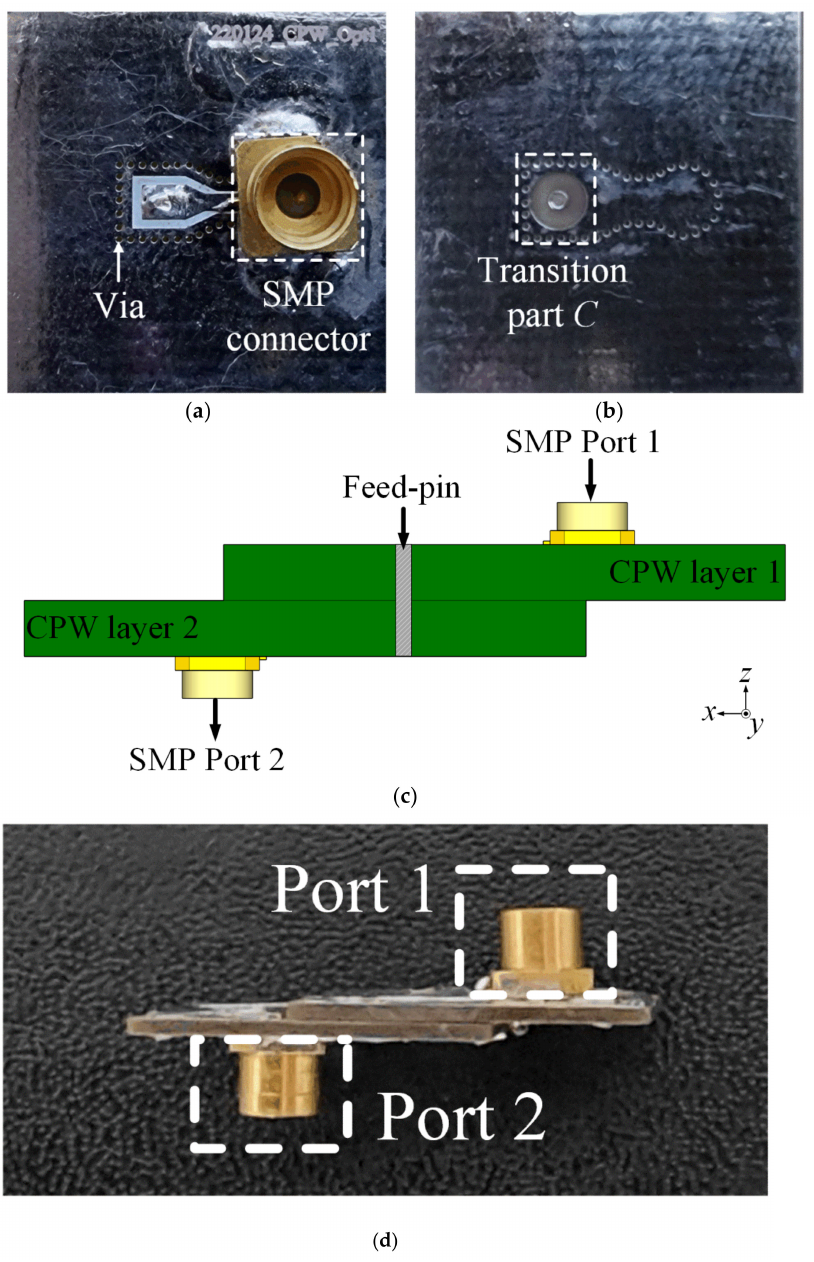
Figure 2. Photograph of the proposed interface layer and back-to-back configuration: ( a ) top view; ( b ) bottom view; ( c ) geometry of the back-to-back configuration; ( d ) fabrication of the back-to-back configuration. Table 2. Comparisons of the interface layer